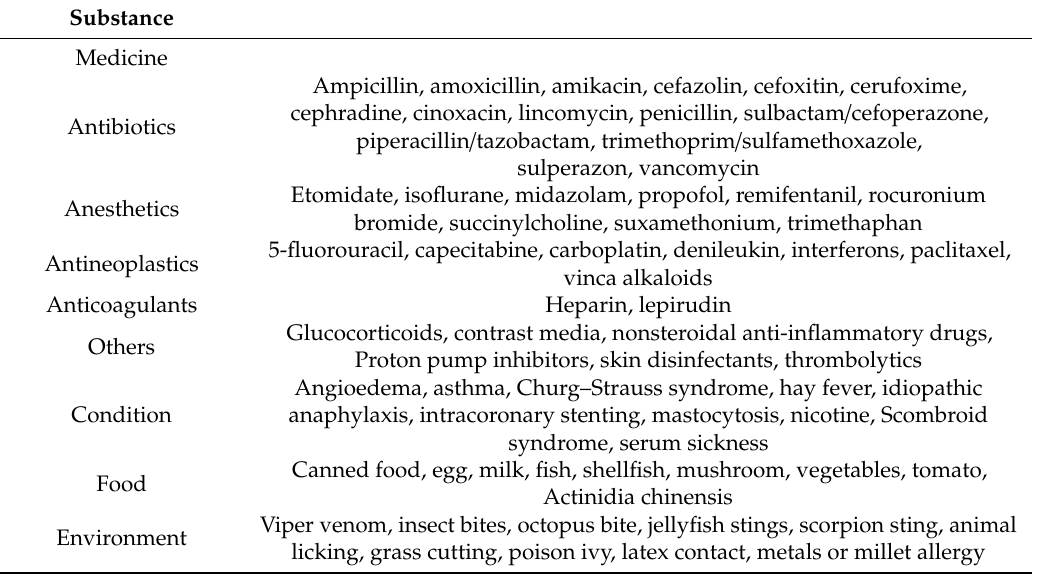
Table 2. Previously reported causes of Kounis